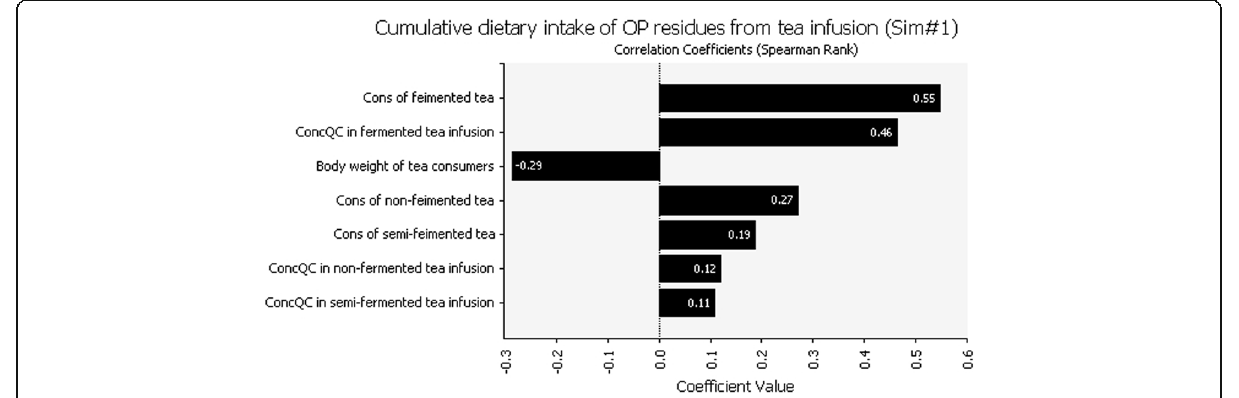
Fig. 1 Sensitivity analysis of cumulative dietary exposure to OP residues from tea infusion